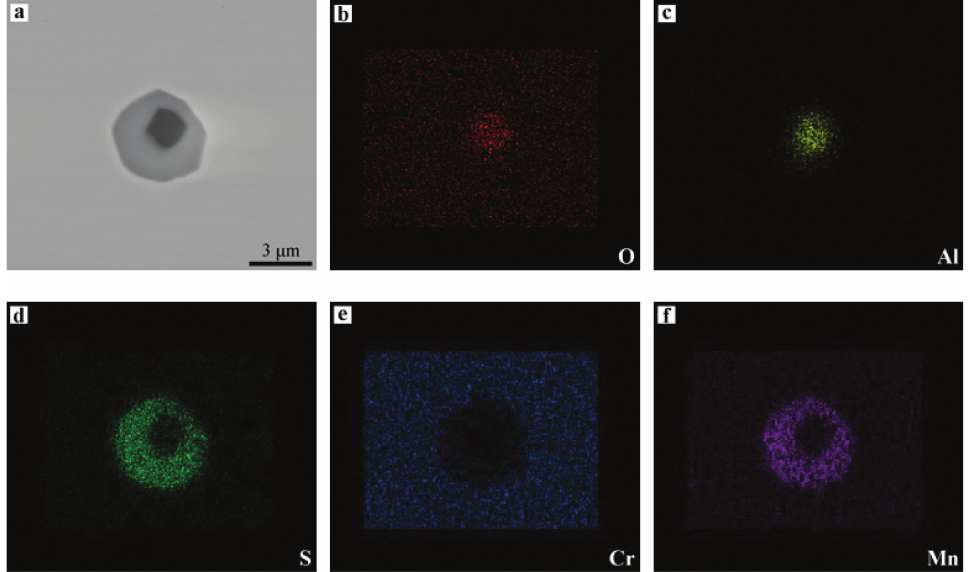
Figure 7: SEM image and element mappings of a typical inclusion in the form two-layer structure observed in the ESR dual alloy